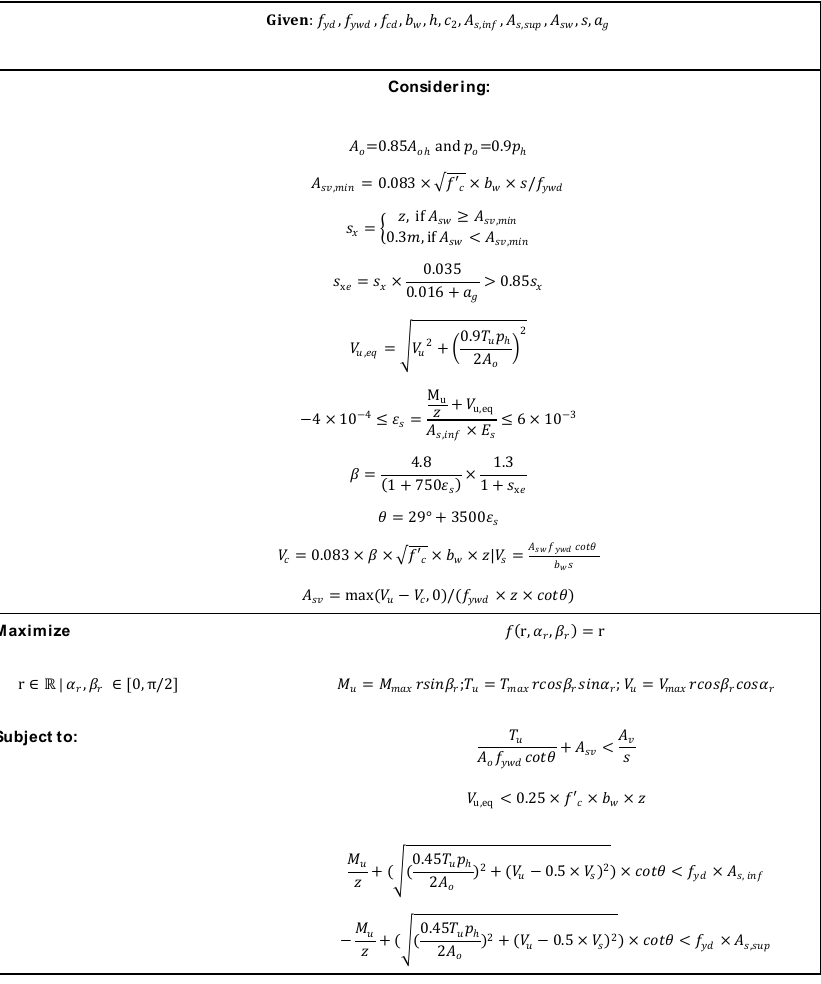
Figure 15: Subroutine for Problem